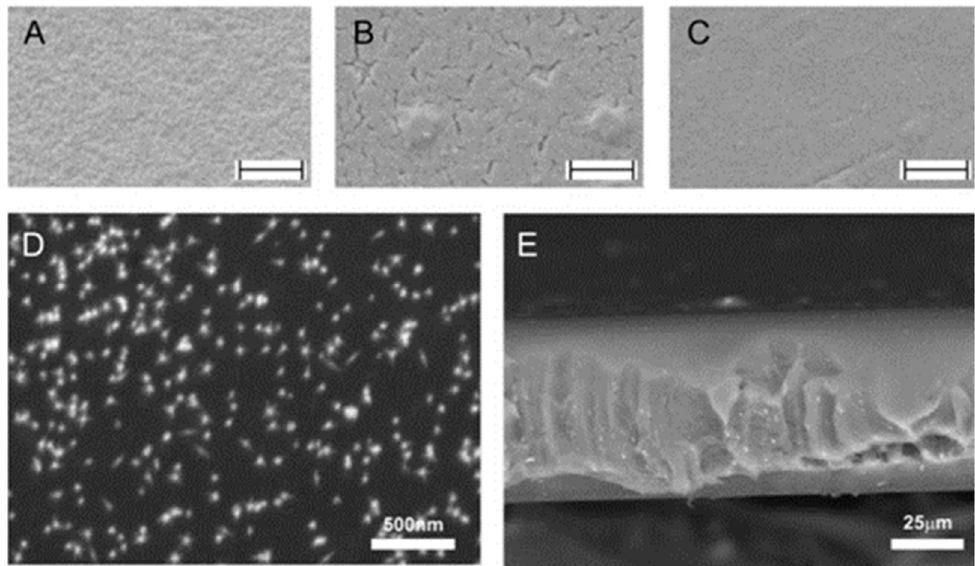
Figure 5. Low-magnification SEM images (20,000×) of film-blank ( A ), filmMIX-Ag/GNS ( B ) and filmMIX-Ag/GNS-C ( C ), scale bar = 1 μ m. ( D ) backscattered electron SEM image of the filmMIX-Ag/GNS-C surface and ( E ) of its side section; scale bar dimensions are indicated in the figures.